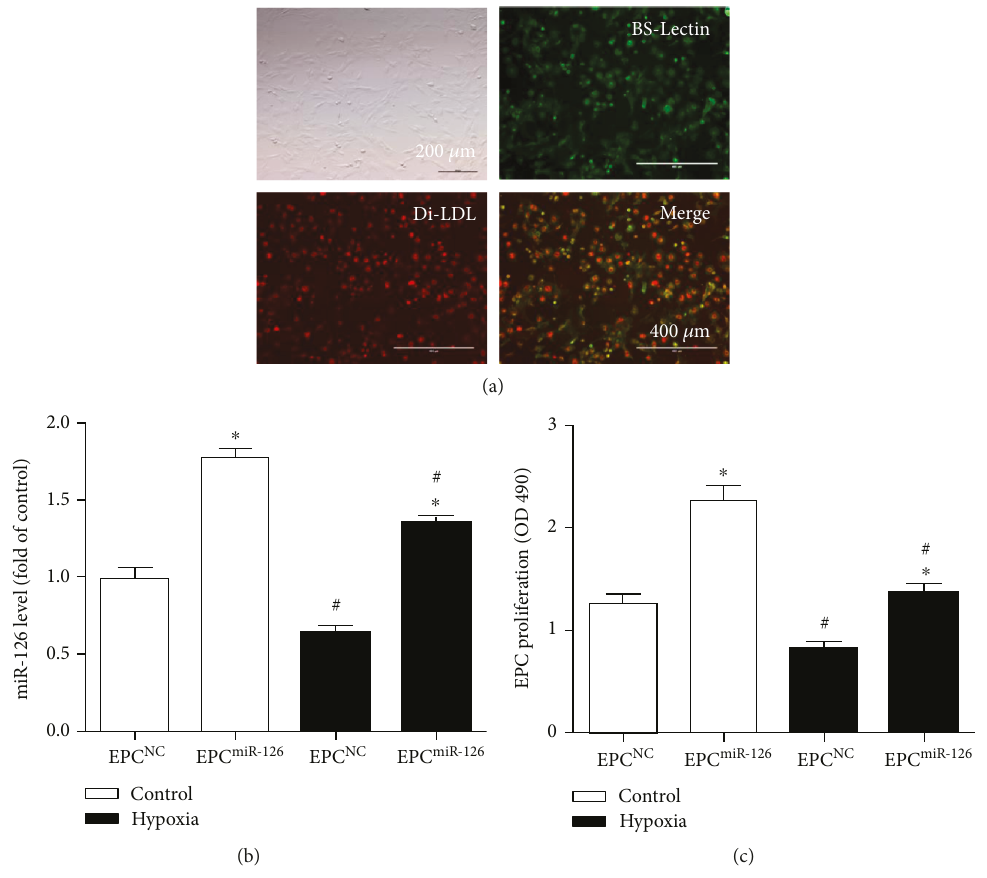
Figure 1: Characterization and transfection e ffi ciency of EPCs and the e ff ect of miR-126 overexpression on the proliferation ability of EPCs and hypoxia-injured EPCs. (a) Representative pictures showing cultured EPCs under transmitter light and fl uorescent light by double- staining analysis. Red: Di-acLDL uptaking; green: Bs-Lectin staining; yellow: Di-acLDL and Bs-Lectin positive cells as EPCs. Scale bar: 400 μ m. (b) qRT-PCR analysis of miR-126 expression in EPCs after lentivirus-miR-126 transfection. (c) MTT assay of EPC proliferation. ∗ p < 0 05 versus EPC NC ; # p < 0 05 versus control, n = 3